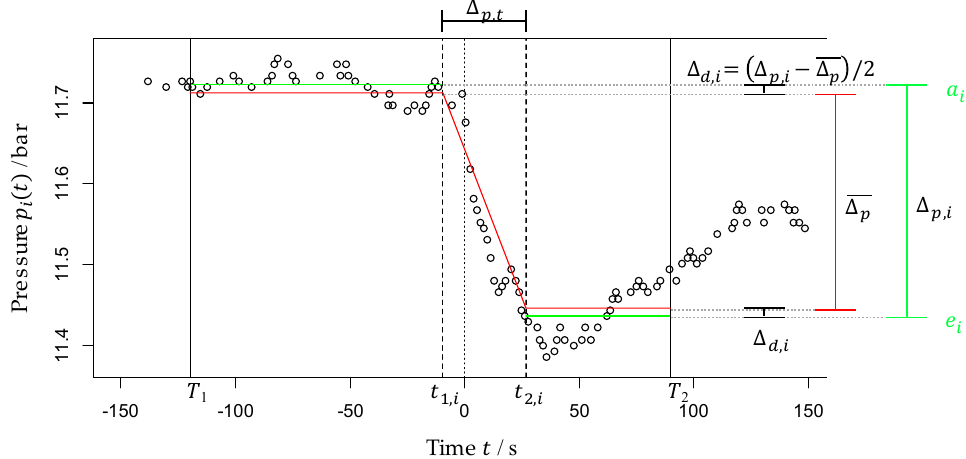
Figure 4. Example for sensor 𝑖 with MoFoDatEv for data evaluation .